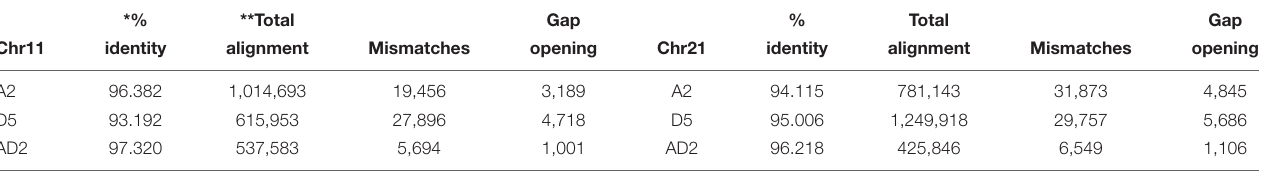
TABLE 5 | Acala N901 BAC alignment to Gossypium arboreum (A 2 ), G. raimondii (D 5 ), G. barbadense (AD2). *% **Total Gap % Total Gap Mismatches opening Chr21 identity alignment Mismatches